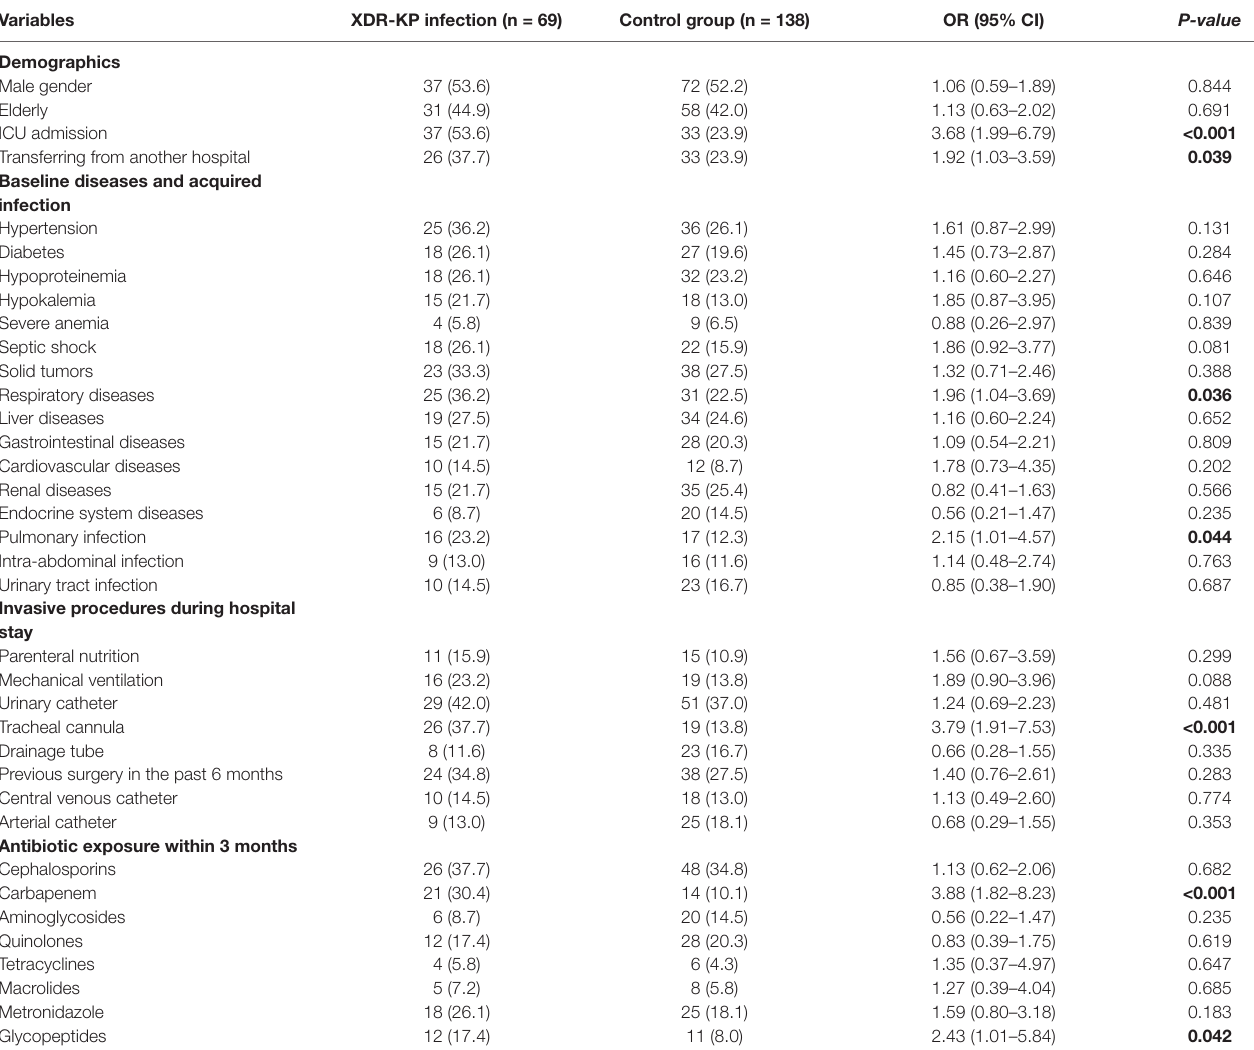
TABlE 3 | Univariate analysis of risk factors for infection with extensively drug-resistant Klebsiella pneumoniae (XDR-KP) and